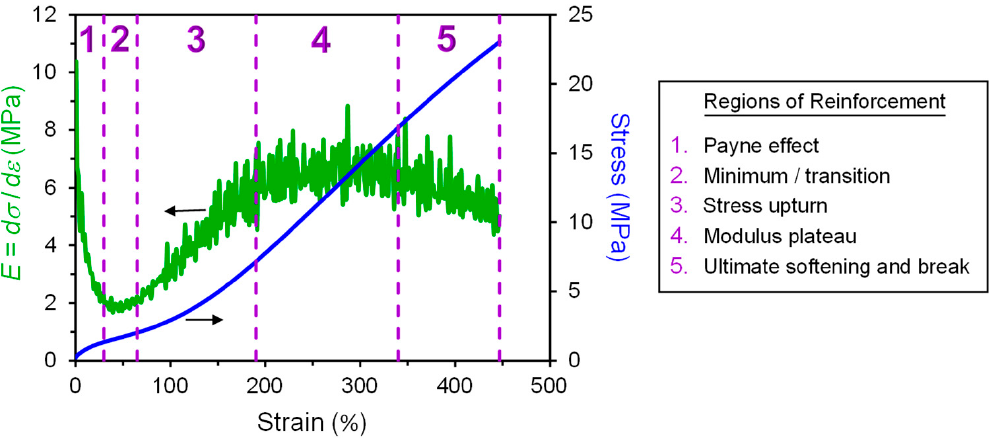
Figure 8. Regions of filler reinforcement illustrated using tensile stress–strain curve and its derivative (slope; modulus ( E )) for N234 CB-filled SBR ( φ = 0.22) with 1.8 phr sulfur. Stress–strain data from Warasitthinon and Robertson [11]. Unitless strain (not %) used when determining E . The dashed vertical lines separate the five regions.